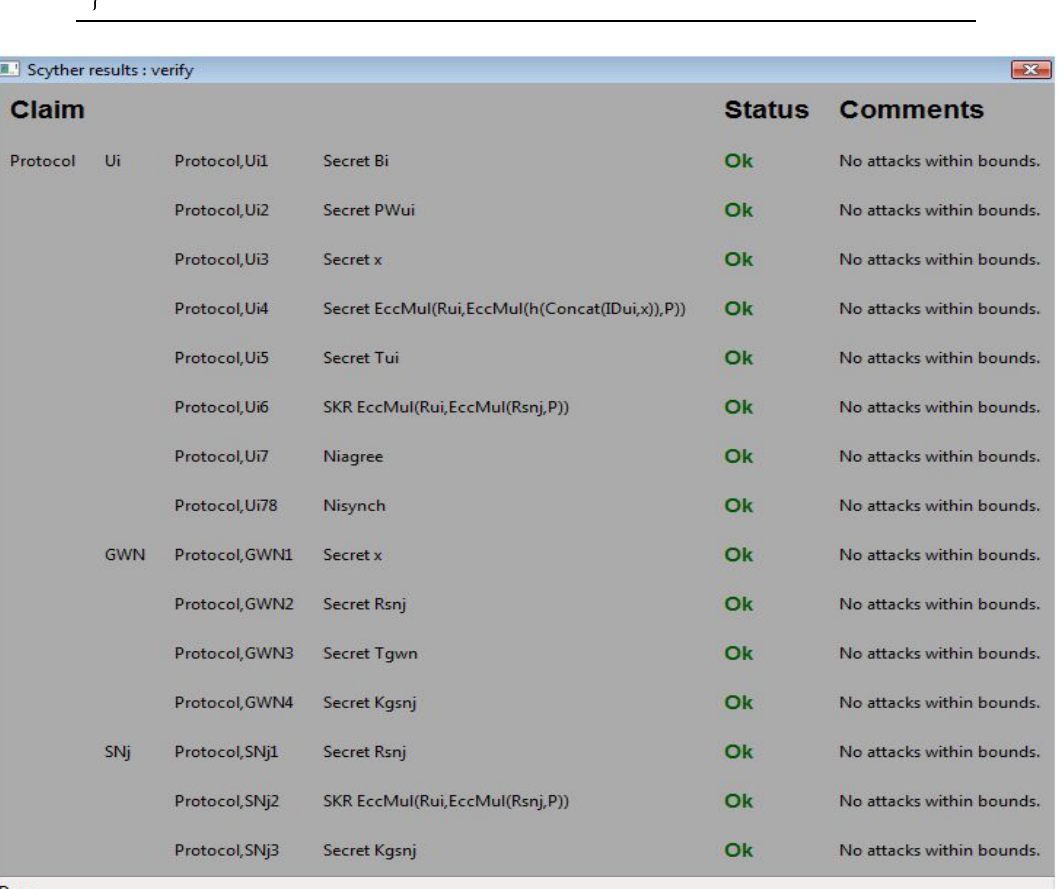
Figure 2. Security verification result obtained using Scyther